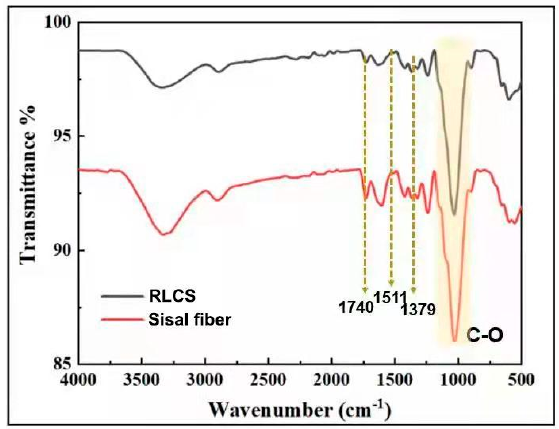
Figure 4. FT − IR spectra of raw sisal fibers and RLCs.